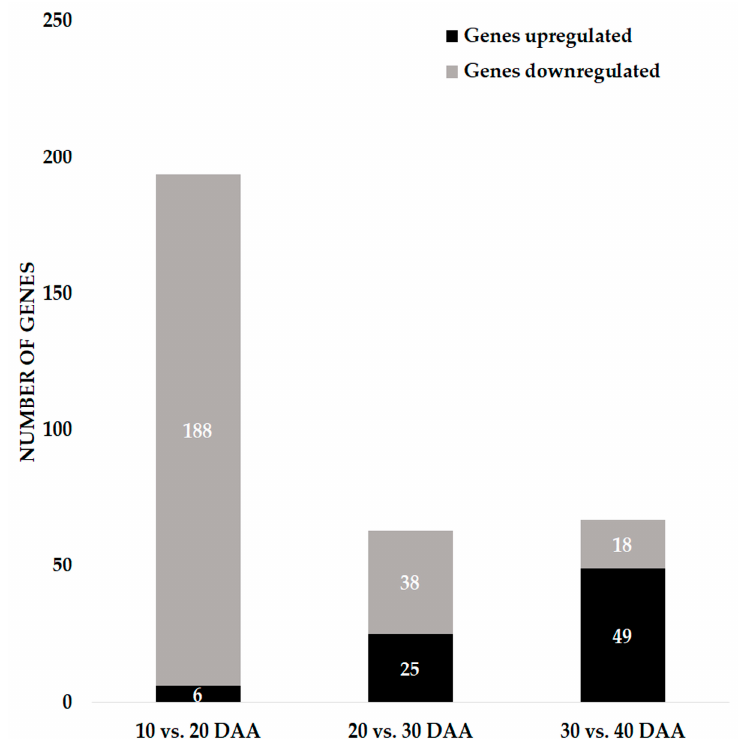
Figure 1. The number of up- and downregulated expressed genes belonging to DNA functional category in developing seeds of P. vulgaris with a minimum of two-fold change in the expression. DAA: days after anthesis.